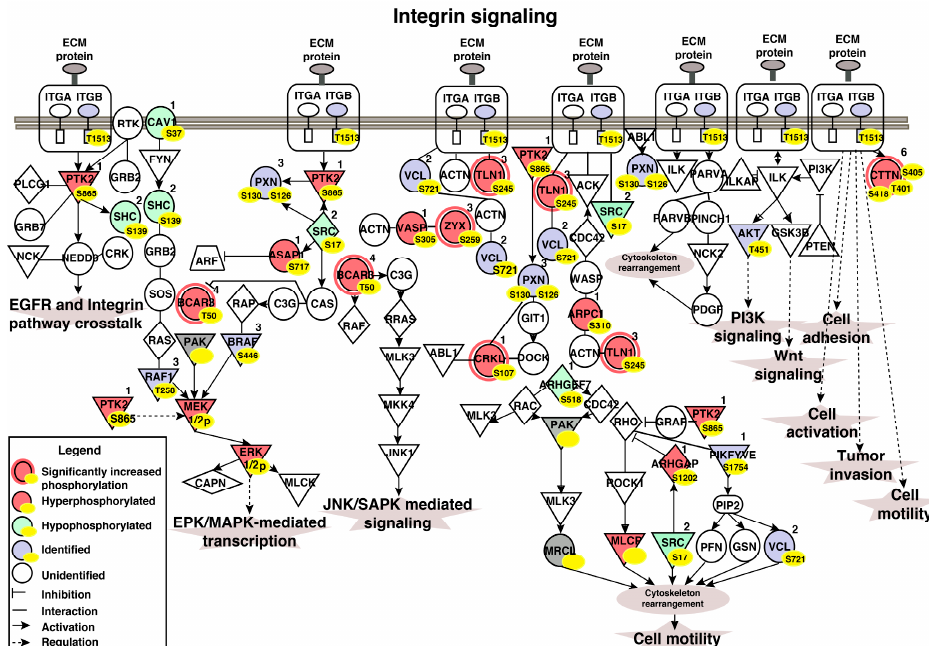
Figure 5. Schematic diagram of enriched integrin signaling pathway in non-type subtype of bladder carcinoma cell lines. Ingenuity pathway analysis lead to the identification of integrin signaling to be most enriched in the aggressive molecular subtype. The dysregulated proteins, the number of phosphopeptides, and the phosphosites identified are highlighted in the pathway.